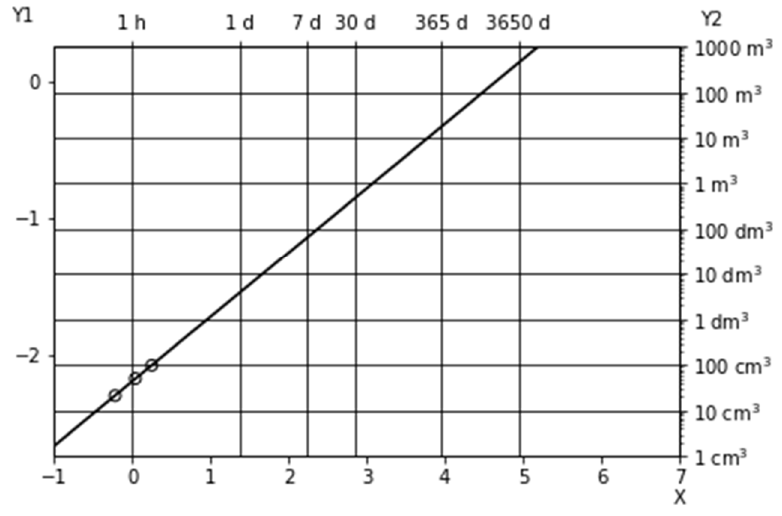
Figure 13. Dependence of the induction time of the combustion (t i ) on the volume/surface ratio of the sludge pellets.